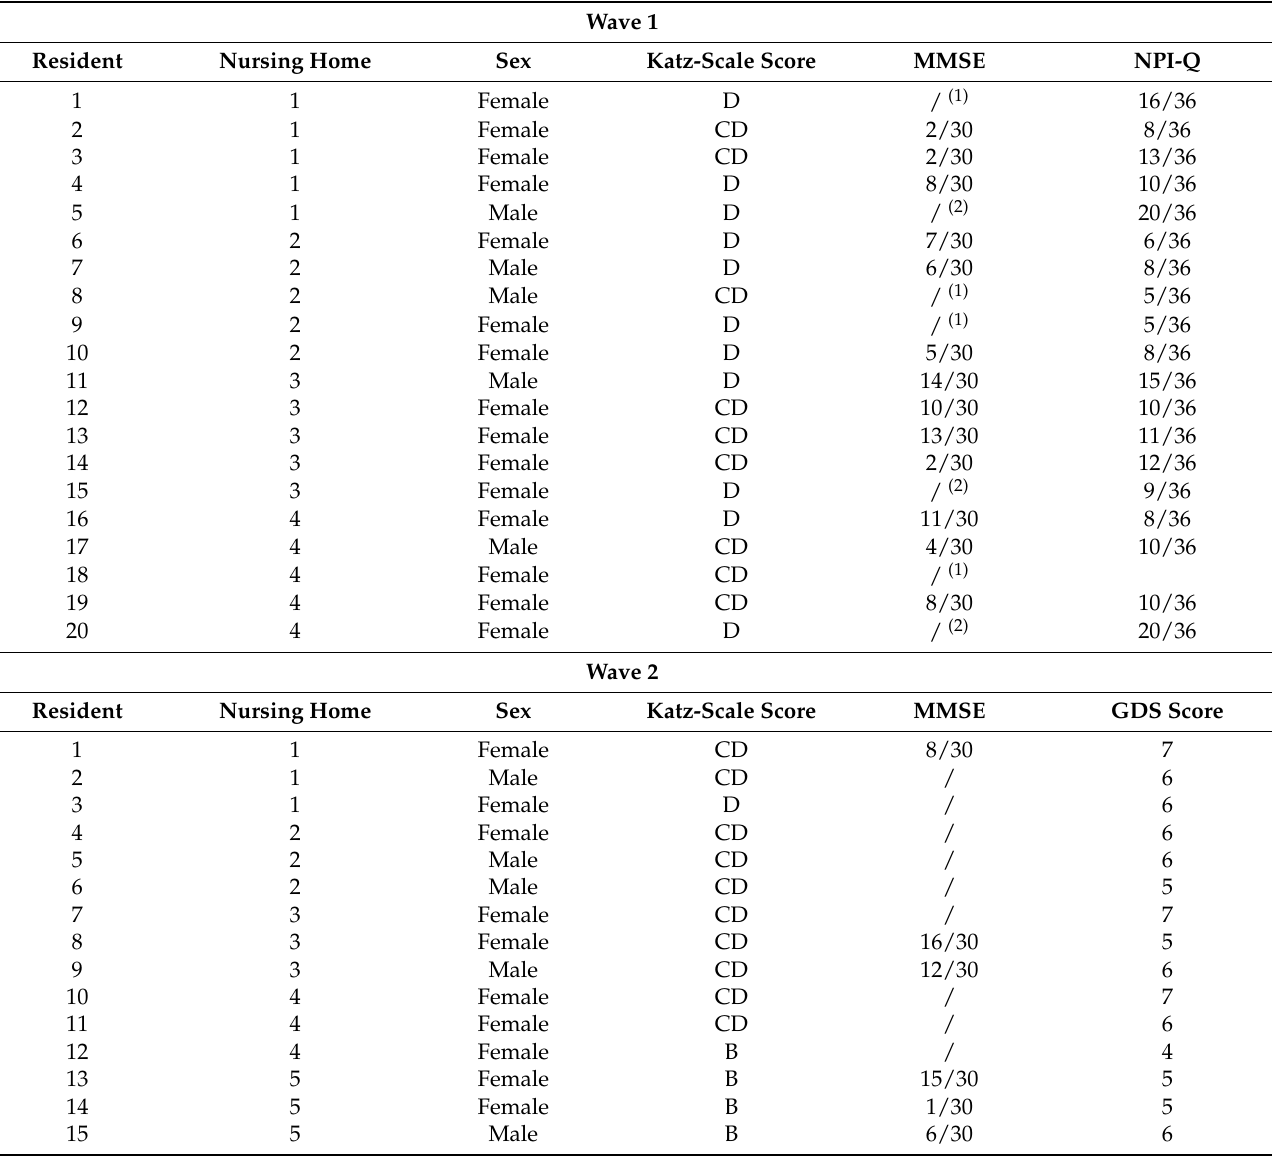
Table 1. The data collection set out to include two waves of NHs. Table 1 shows the main characters displayed per resident and presents the description of the